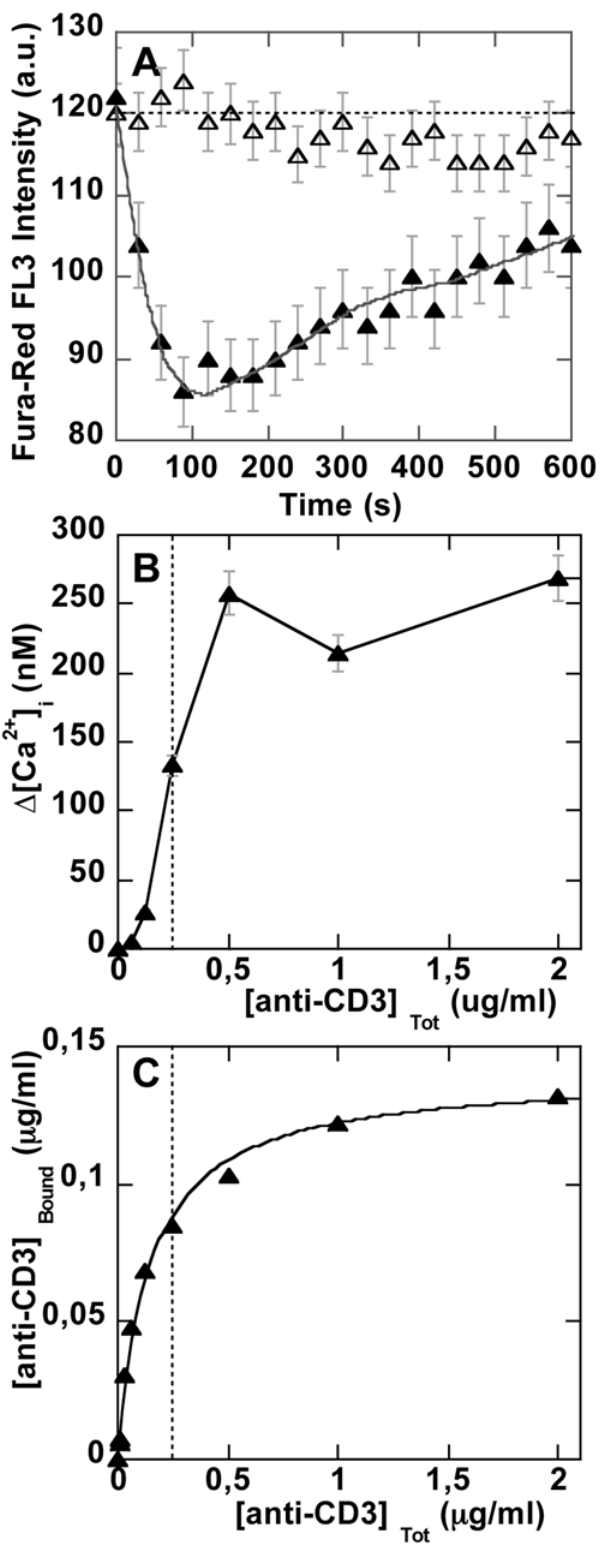
Figure 5. Cell TCR/CD3 occupation and calcium signal trigger- ing by soluble anti-CD3. T cells (2 6 10 6 /ml in PBS buffer) loaded with 10 m M Fura-Red calcium probe were treated with increasing concen- trations of soluble FITC-anti-CD3 (0.075 to 2 m g/ml) at time t=0. (A) Time-dependent Fura-Red fluorescence intensity variation is shown for